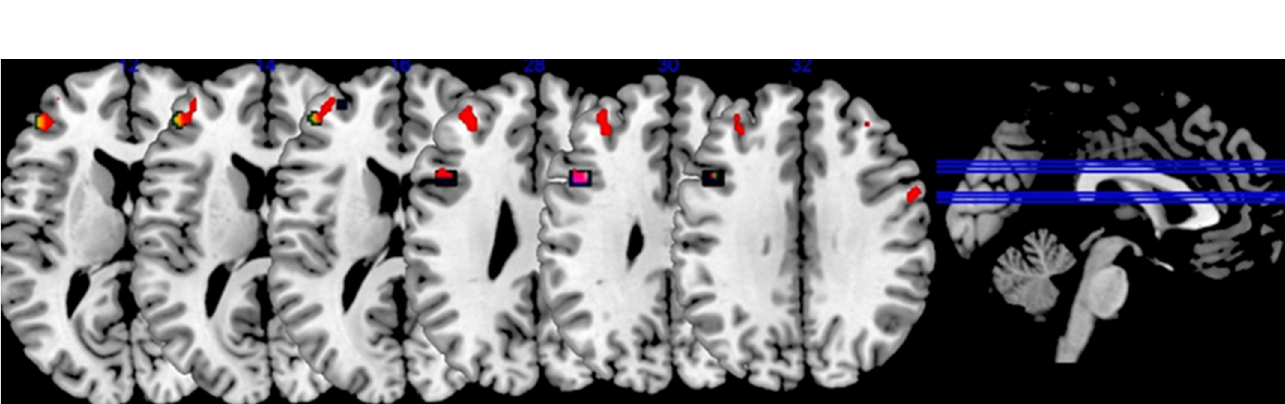
Fig 3. Urbanicity-by- COMT interaction results from discovery sample showing spatial overlap with US and Italian replications (n = 487). Areas of spatial overlap between the discovery results and those at replication. Red indicates the discovery sample, blue the US replication and yellow the Italian replication, while other colors resulted from overlap. The statistical threshold for display purposes is p < 0.05 (uncorrected). Left = Left.